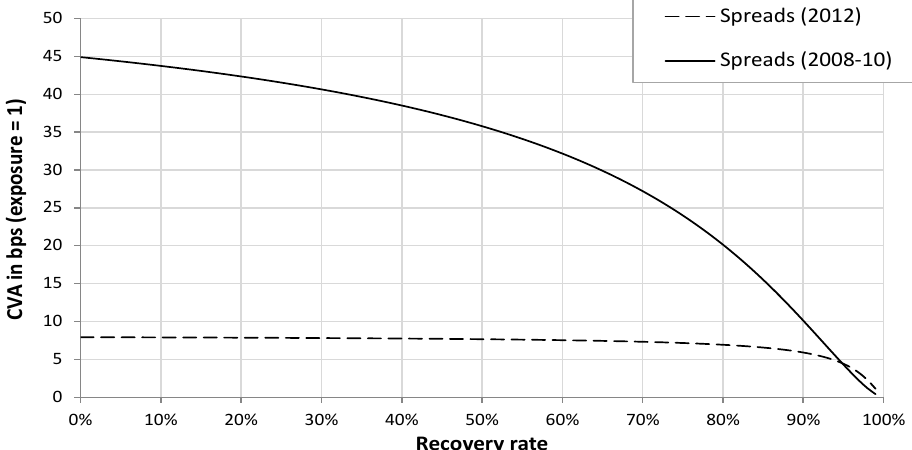
CVA for a 10-year interest rate swap evaluated in a ‘low’ spread regime (e.g. 2012)